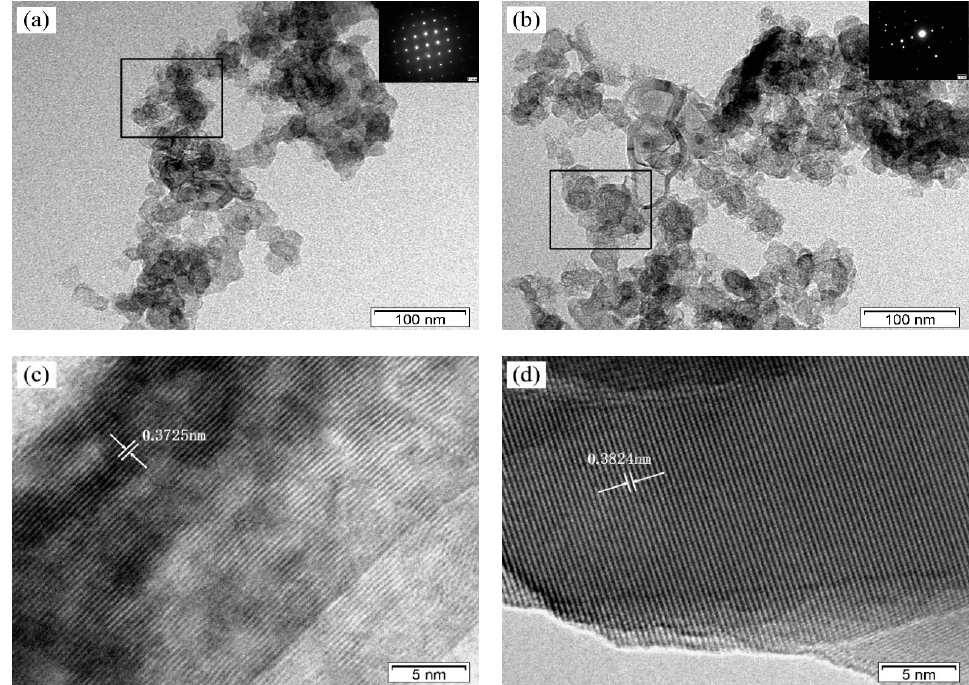
Figure 5. ( a ) TEM image of the sample before gamma ray irradiation; the inset shows the corresponding SAED pattern; ( b ) TEM image of the sample after gamma ray irradiation; the inset shows the corresponding SAED pattern; ( c ) HRTEM image of the sample before gamma ray irradiation; ( d ) HRTEM image of the sample after gamma ray irradiation.